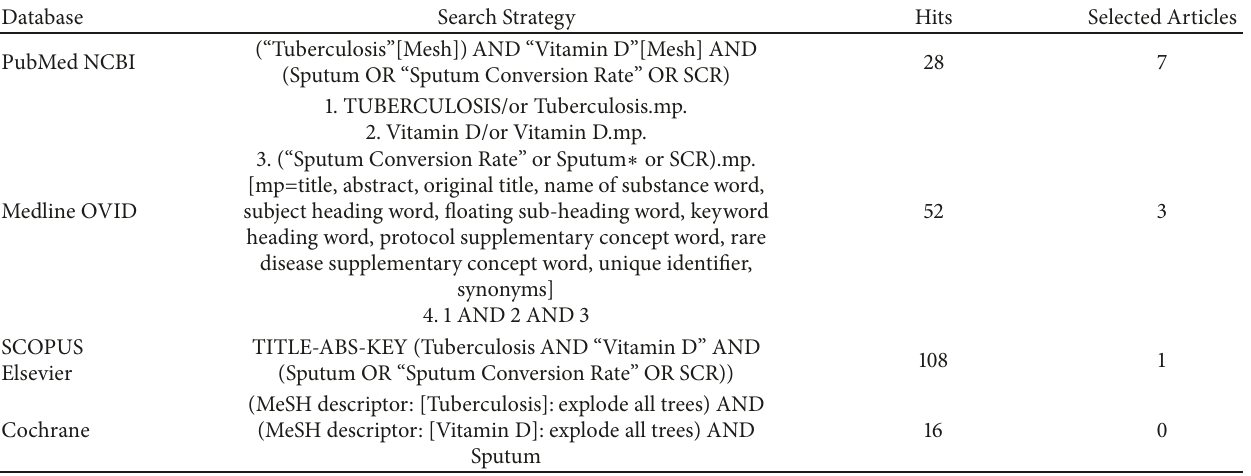
Table 1: Search strategy applied in searching for evidence in the four electronic databases.